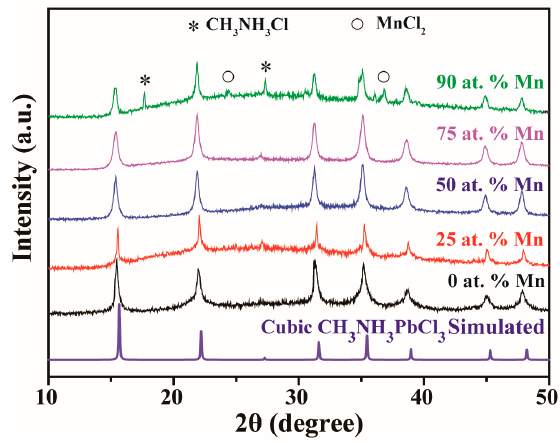
Figure 1. XRD pattern of Mn 2+ -doped CH 3 NH 3 PbCl 3 PNCs with different concentration of Mn 2+ (nominal concentration). The asterisks and circles denote the characteristic XRD peaks of CH 3 NH 3 Cl and MnCl 2 , respectively.